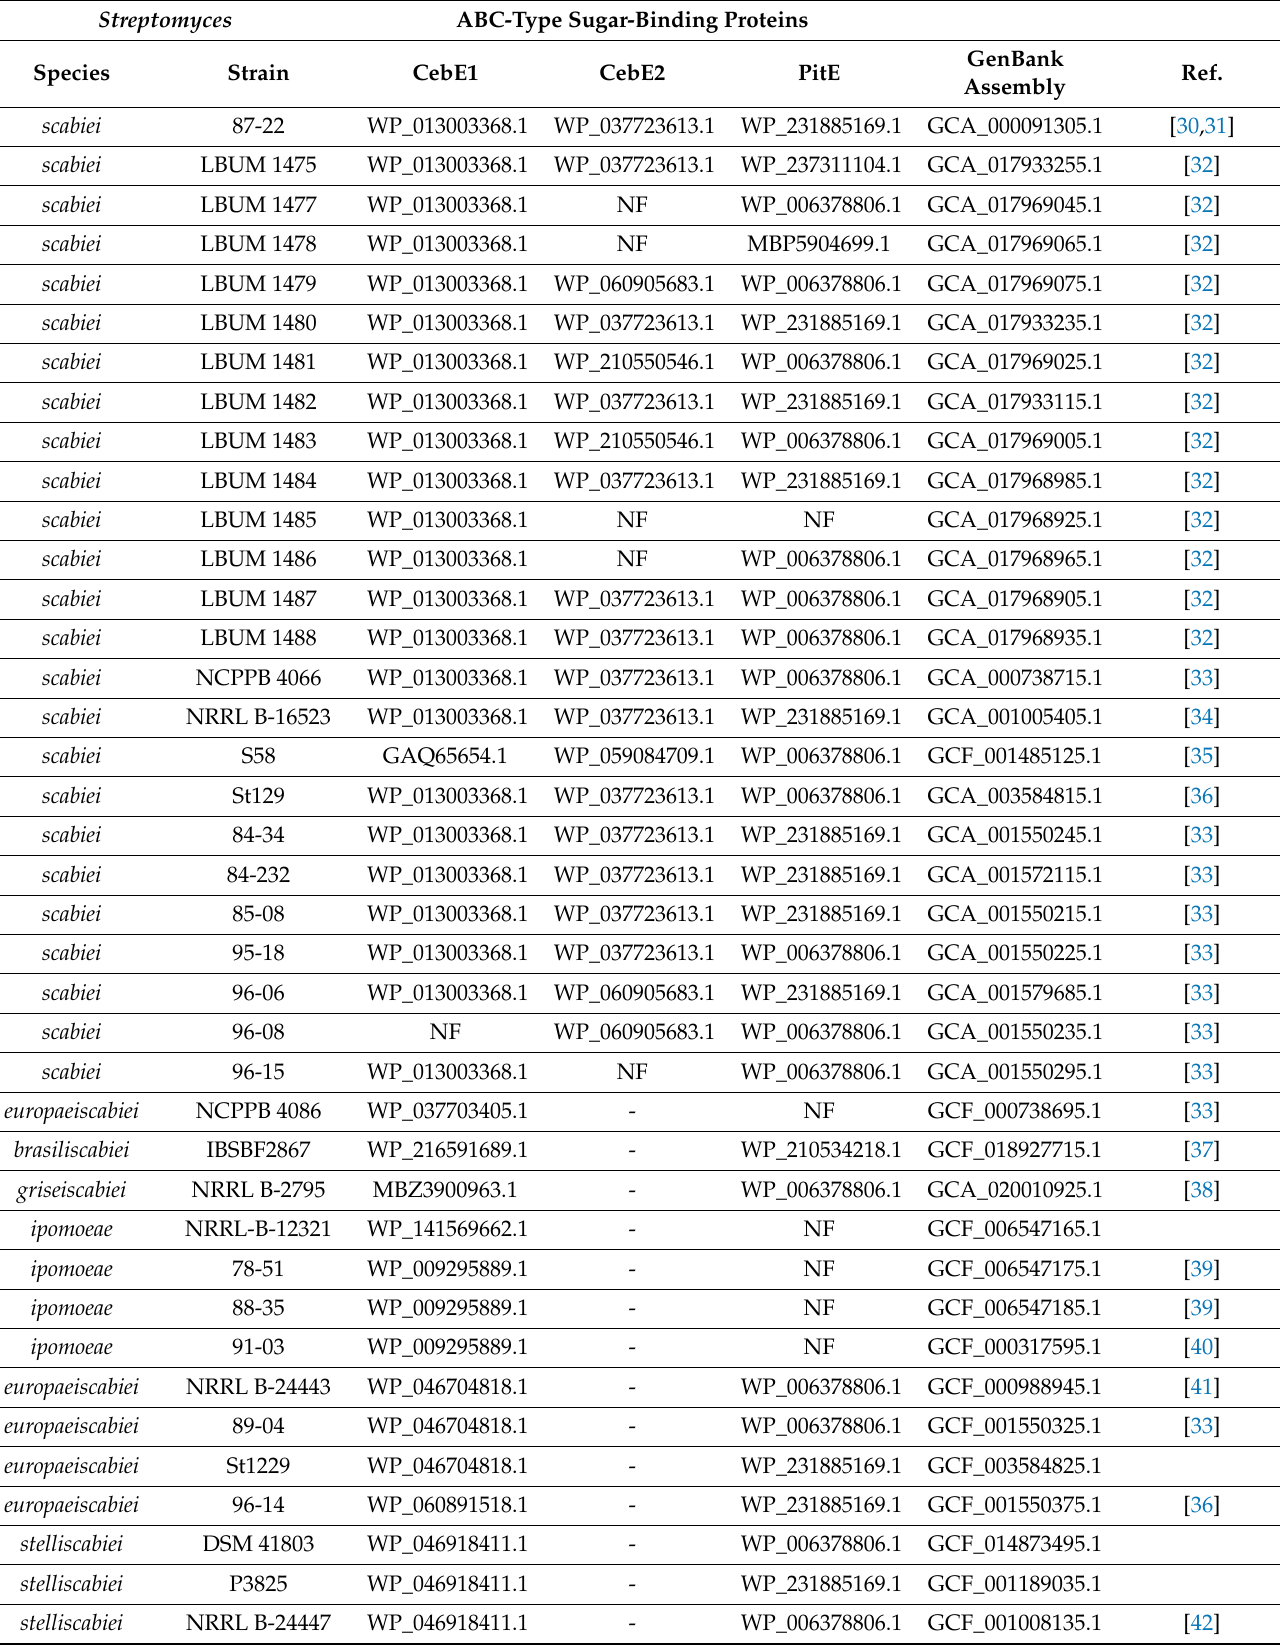
Table A2. Genomes and protein accession numbers of strains investigated in this